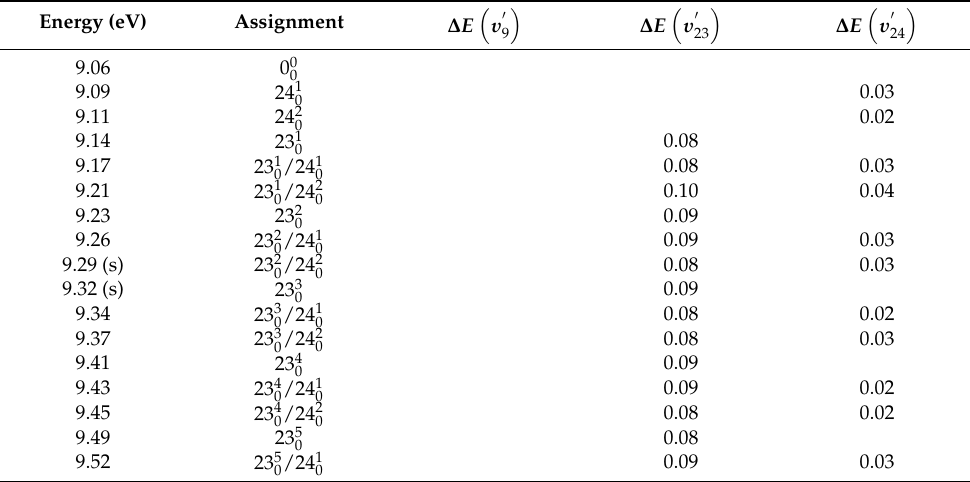
Figure 12. Vibrational progressions in the 9.0–10.8 eV energy range of the absorption Band VI of ( top panel) and 5-bromopyrimidine ( bottom panel). Table 7. Proposed vibrational assignments in the 9.0 − 10.8 eV absorption band of 5BrPyr (Band VI). ∆ E (in eV) represents the energy of one extra quanta in the vibrational progression. The symbol “/” means both modes are involved; the symbol “;” means two alternative